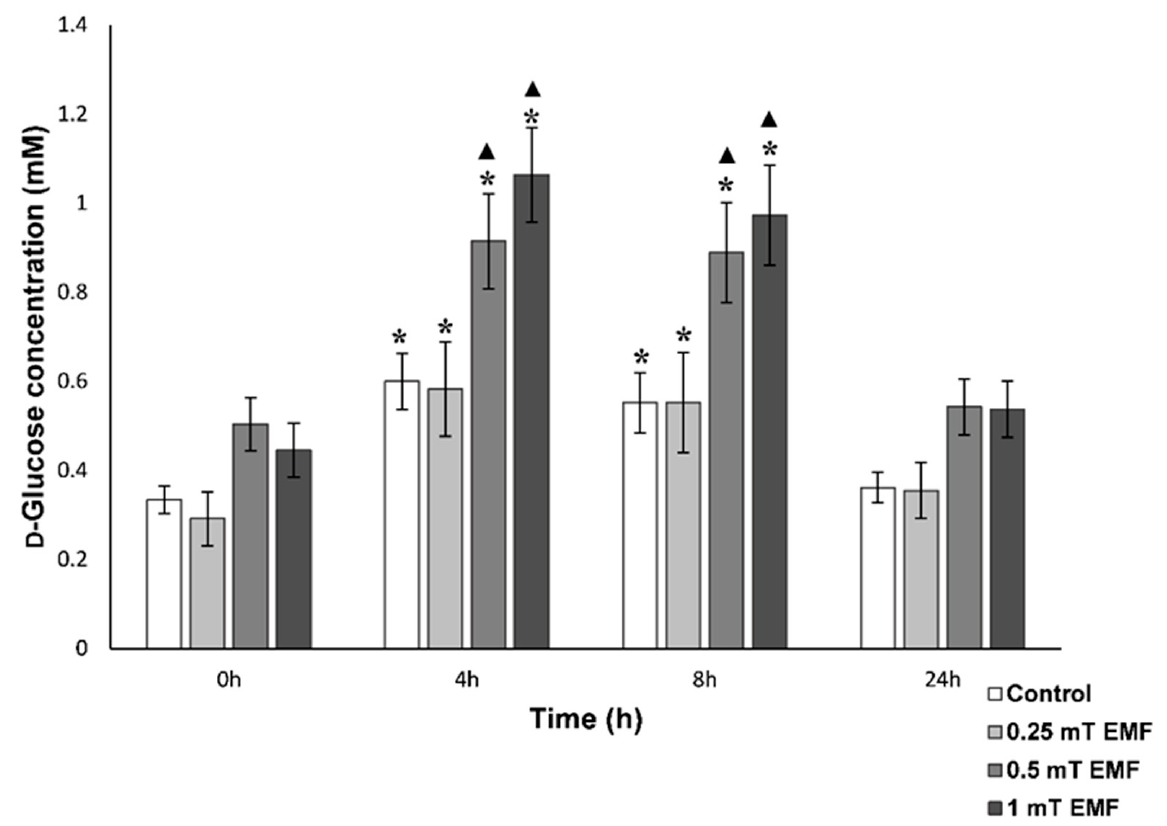
Figure 2. D -Glucose concentration over a 24 h period in control conditions and exposure to EMF at 250 µT, 500 µT, 1000 µT strength. Sample times consisted of 0 h (09:00 a.m.), 4 h (13:00 p.m.), 8 h (17:00 p.m.), 24 h (09:00 a.m.). Values are presented as mean ± SEM, * is the significance from the 0 h within respective treatments, ▲ is the significance from the control group for each treatment at respective sampling times (*, p < 0.05), ( ▲ , p < 0.05). N = 10 individuals for control and N = 10 individuals for EMF per treatment, total samples of N = 40 control, N = 40 EMF.